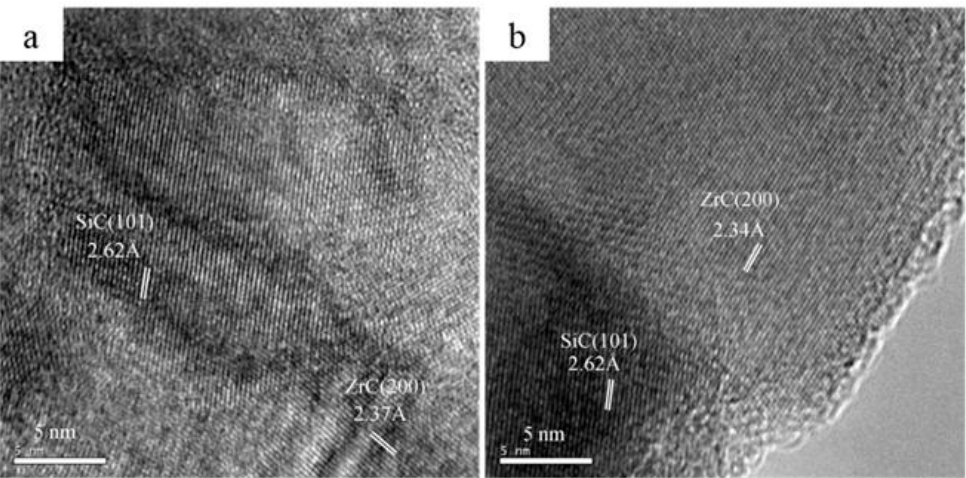
Figure 6. HR-TEM images of the as-cured fibers obtained via the H 2 –Ar process up to ( a ) 1400 and ( b ) 1600 °C.